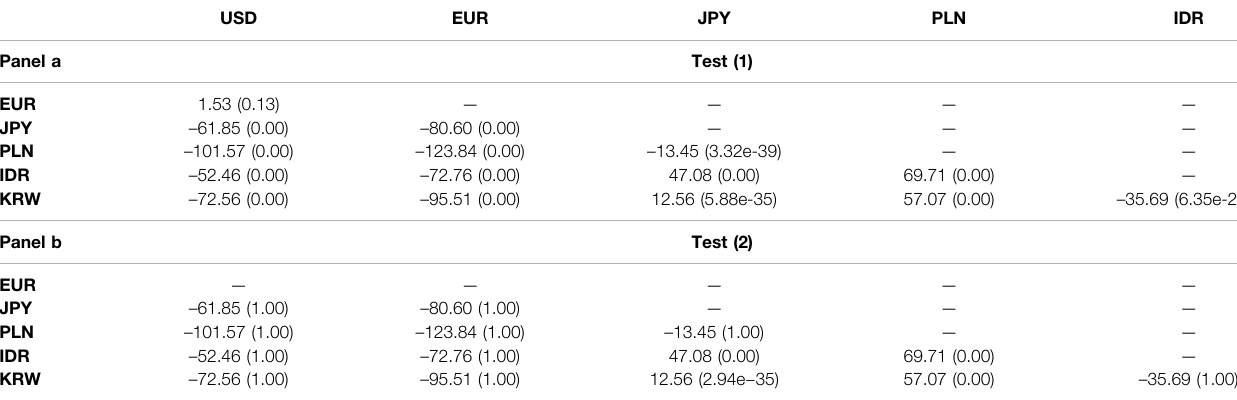
TABLE 3 | Test results of net pairwise spillover between systematic and idiosyncratic volatility.